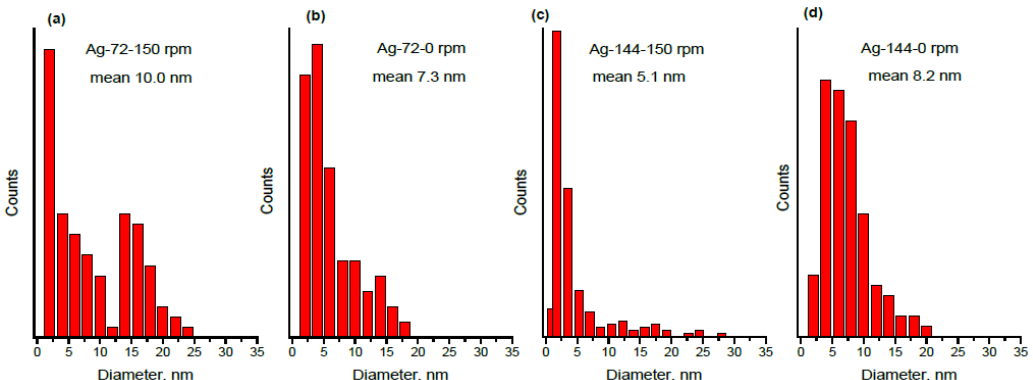
Figure 9. TEM images of the samples ( a ) Ag-72-150 rpm, ( b ) Ag-72-0 rpm, ( c ) Ag-144-150 rpm and